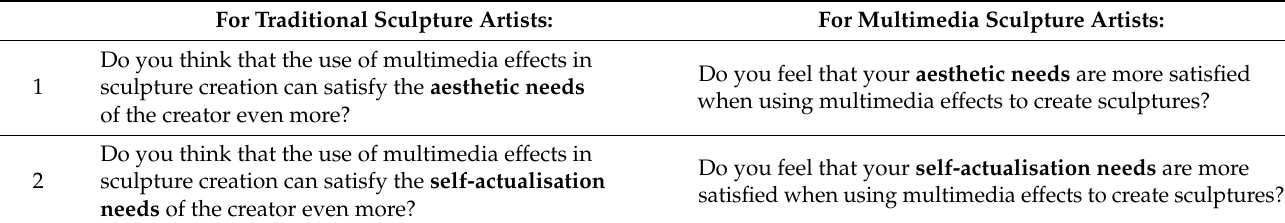
Table 1. Pre-test interview